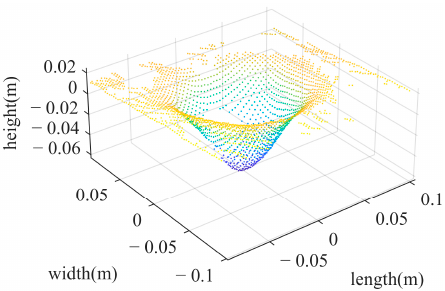
Figure 10. Removal of Flat Points to Obtain 3D Point Clouds of Diseased Areas.